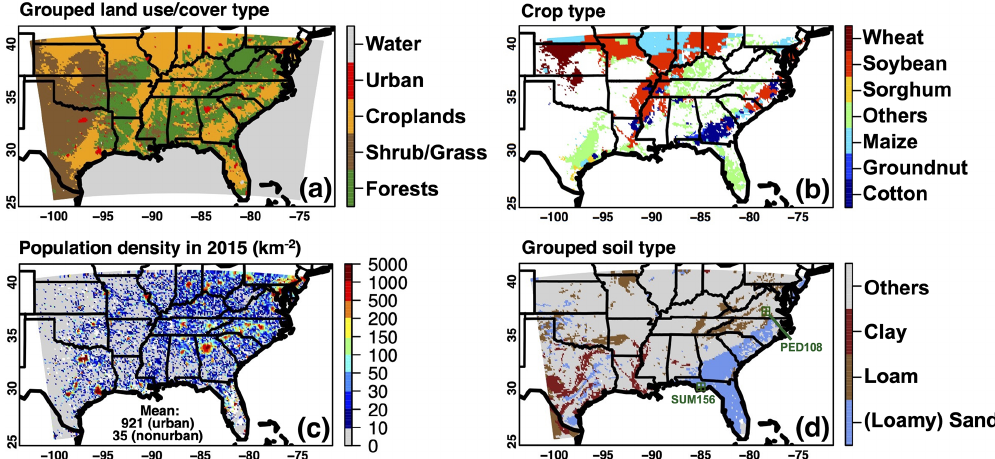
Figure 1. (a) Grid-dominant land use/land cover types grouped from the original 20-category model input (Fig. 1c in Huang et al., 2021) based on the method in Table S1, (b) grid-dominant crop type over cropland-dominant regions, (c) gridded population density in 2015, and (d) highlighted grid-dominant soil types of sand/loamy sand, loam, and clay which are most relevant to discussions in this paper. The original soil type input from the State Soil Geographic database is shown in Fig. S1 in Huang et al. (2021). Locations of the two CASTNET sites for the case studies are denoted in